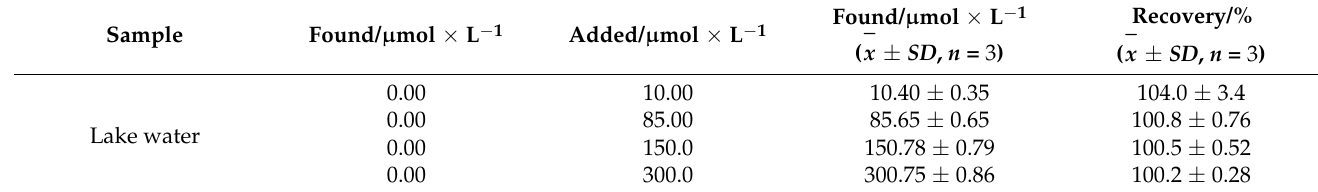
Table 1. Determination results and recoveries of CAP in water